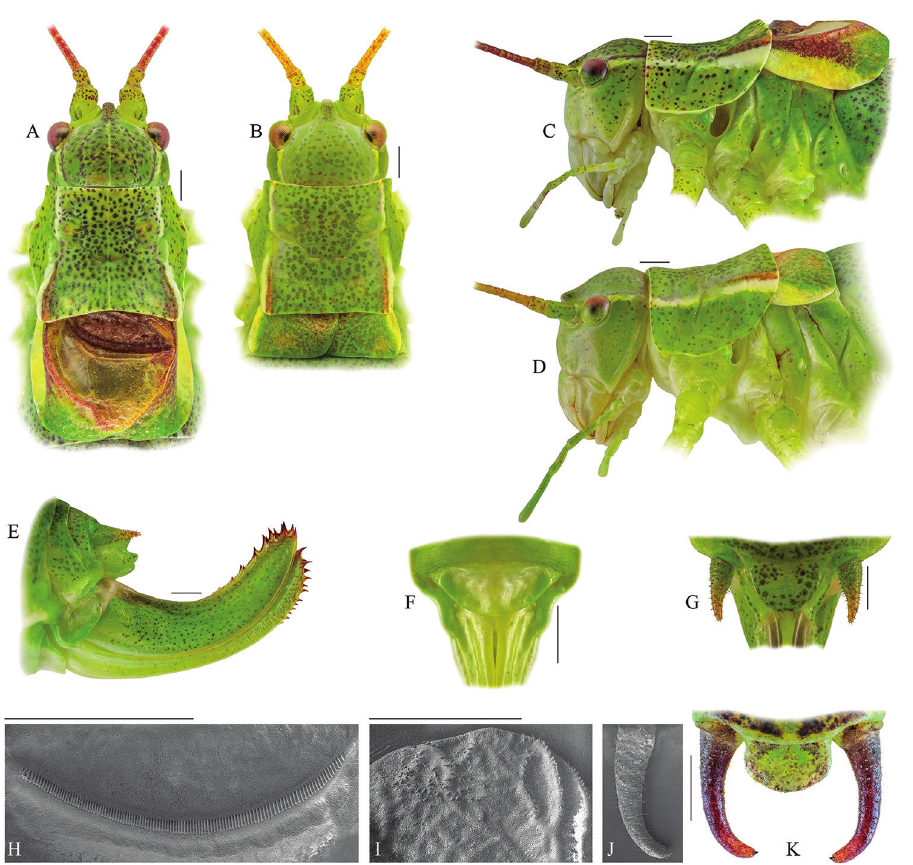
Figure 2. Photographs of the typical eidonomy of Isophya bucovinensis sp. n. male ( A, C, H, J, K ) and female ( B, D, E, F, G, I ). A, B head, pronotum and tegmina in dorsal view C D head, pronotum and tegmina in lateral view E ovipositor in lateral view F female subgenital plate G female cerci in dorsal view H male stridulatory file (SEM) I female stridulatory bristles (SEM) J male cercus (SEM) K male cerci in dorsal view. Scale bars 1